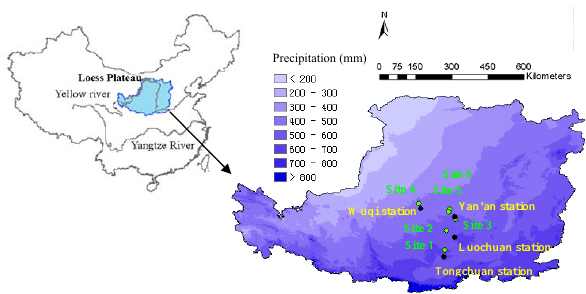
Fig. 1. Location of the six sites in this study and the adjacent long- term meteorological stations in the Loess Plateau,